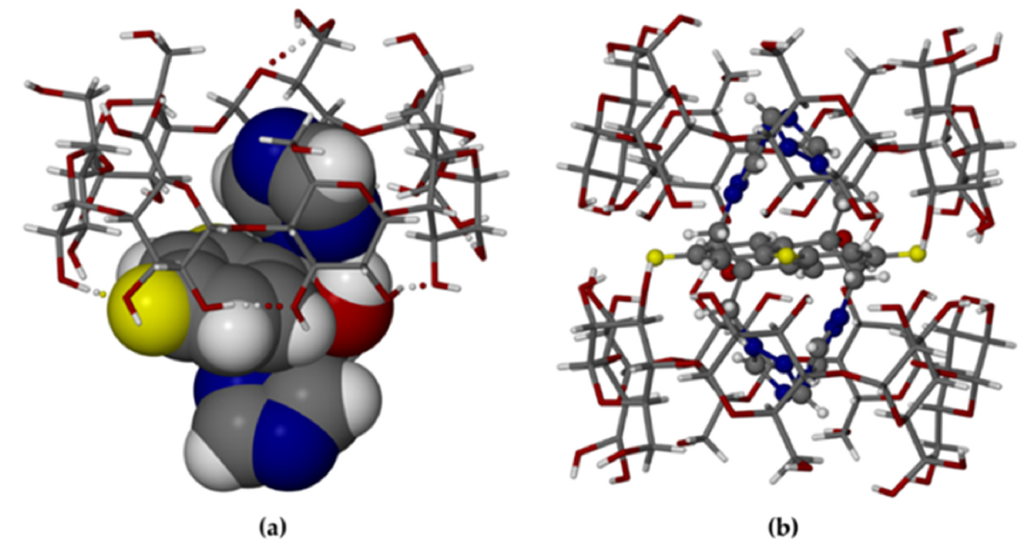
Figure 4. The complex MBCDFLU: ( a ) the asymmetric unit (water oxygen atoms omitted for clarity); ( b ) the ( β -CD) 2 ⋅ FLU complex unit with disordered FLU components.